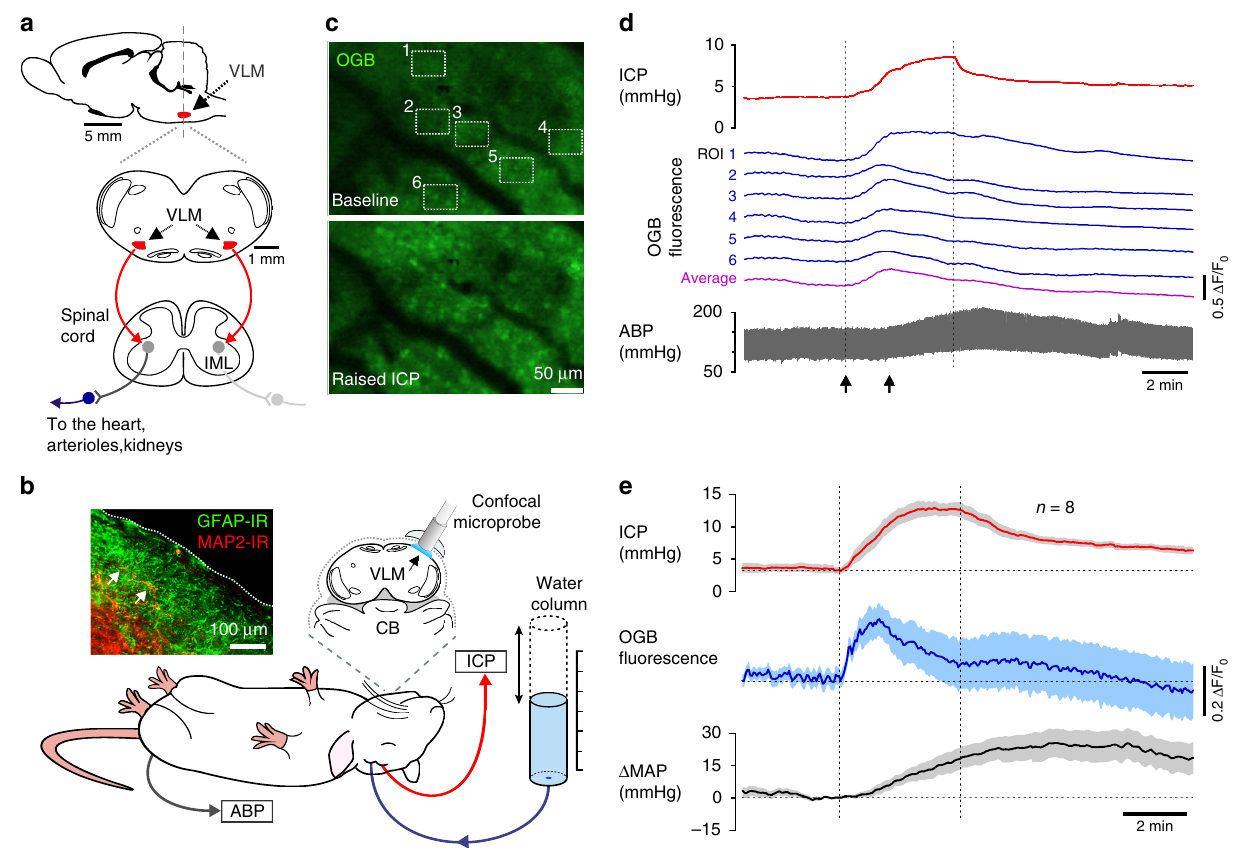
Fig. 3 Responses of brainstem astrocytes to decreases in brain perfusion. a Schematic drawings of the rat brain in parasagittal and coronal projections illustrating the anatomical location of the sympathetic control circuits in the ventrolateral medulla oblongata (VLM) of the brainstem sending excitatory projections to sympathetic preganglionic neurons of the intermediolateral (IML) spinal cord. Astrocytes that reside within and in close proximity to the brainstem sympathetic control circuits of the VLM are hypothesized to function as intracranial baroreceptors. b Diagram of the experimental setup in anesthetized rats instrumented for the recordings of intracranial pressure (ICP), systemic arterial blood pressure (ABP) and confocal microprobe imaging of changes in Oregon Green BAPTA 1 AM (OGB) fl uorescence in the most-ventral regions of the VLM. Inset: a representative image showing that in this part of the brainstem the marginal layer contains a dense network of astroglial processes and cell bodies (identi fi ed by GFAP immunoreactivity) and only sparse neurons and neuronal fi bers (identi fi ed by MAP2 immunoreactivity; arrows point to the neuronal cell bodies that are closest to the ventral surface